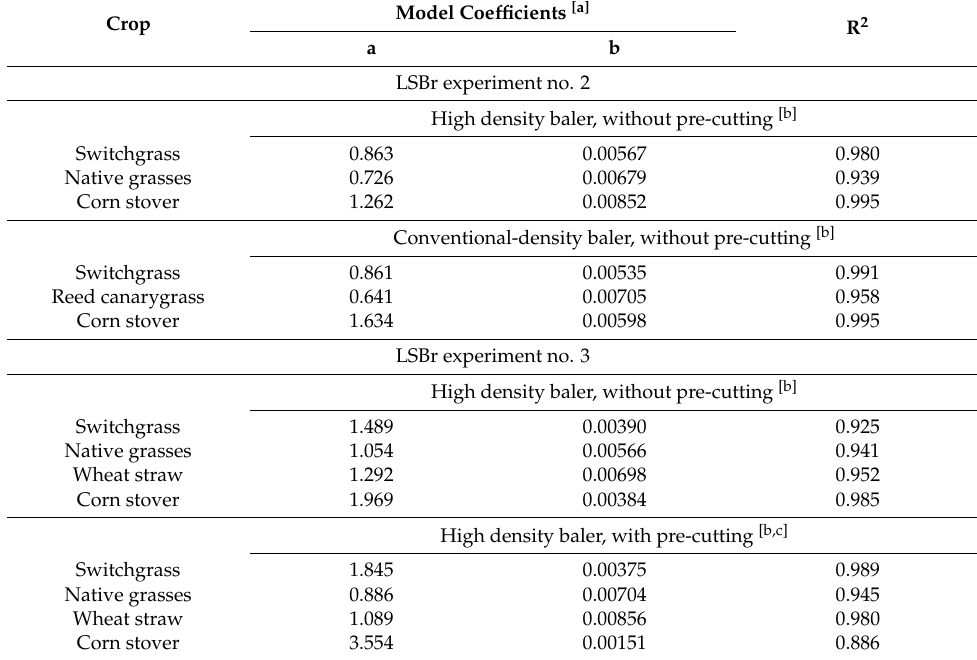
Table 5. Coefficients for exponential model (Equation (1)) of large square baler specific energy requirements as function of bale density (both on a dry basis).